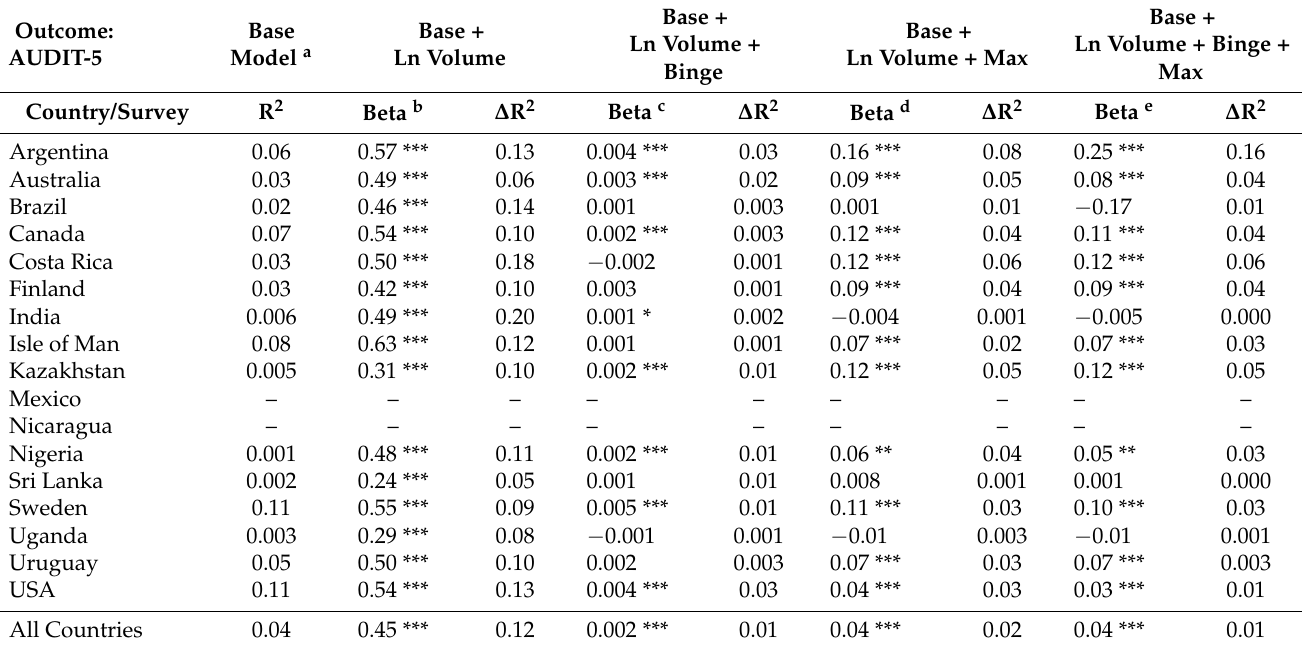
Table 4. Male Regressions Predicting